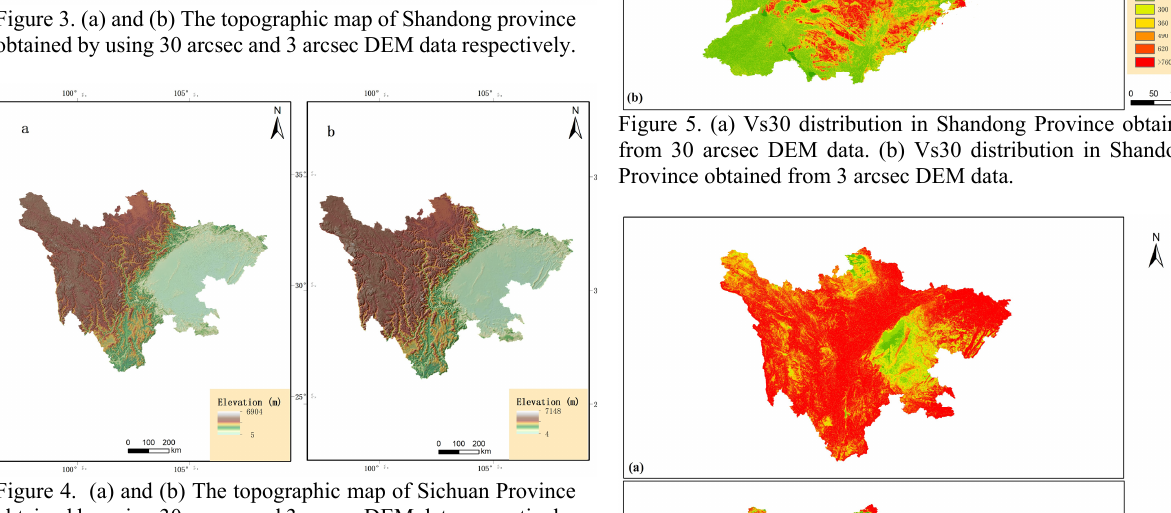
Figure 4. (a) and (b) The topographic map of Sichuan Province obtained by using 30 arcsec and 3 arcsec DEM data respectively.